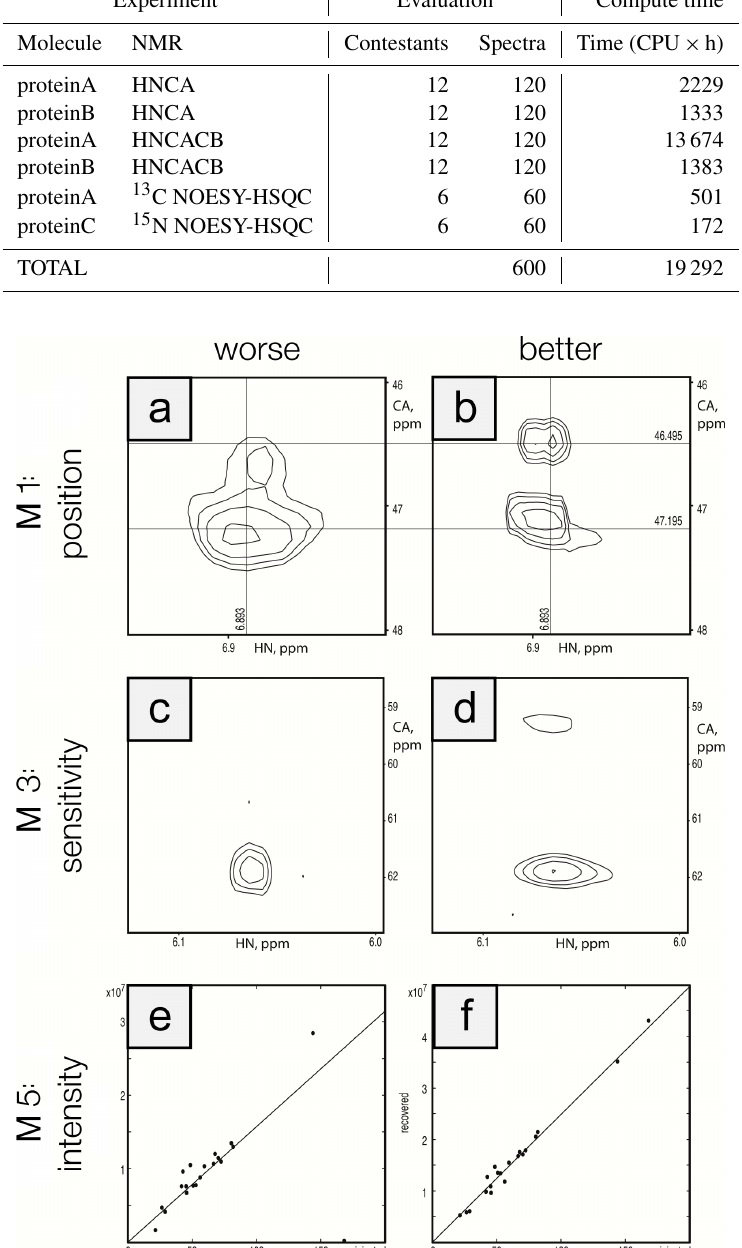
Figure 5. Visualization of metric performance. Reconstructions that perform relatively worse (a, c, e) and that perform relatively well (b, d, f) are shown for each of the metrics M1 (row 1), M3 (row 2), and M5 (row 3) on the protein A/HNCA challenge data. The crossing lines in panels (a) and (b) intersect where a pair of synthetic peaks has been injected. The peaks in panel (a) are clearly offset and distorted. Panels (c) and (d) show a pair of weak peaks, only one of which is recovered in panel (c) . Panels (e) and (f) show correlations between injected and recovered synthetic peak